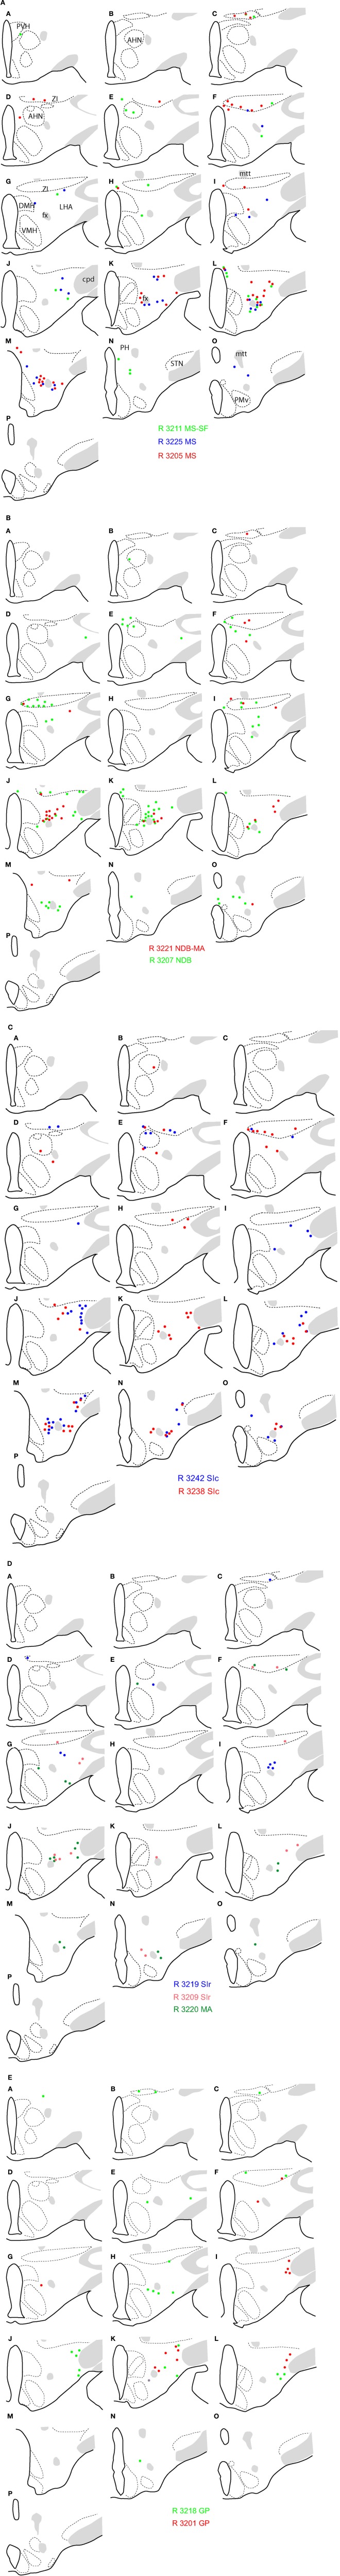
(A–E) Distribution of FG-MCH neurons in the posterior hypothalamus after different FG injections in the basal telencephalon. This distribution is mapped on coronal drawings of the caudal hypothalamus arranged from rostral (a) to caudal (p). These drawings were produced from Nissl stained sections and mapping was made with regard to the distribution of MCH cell bodies from an adjacent series of section. Therefore, results of all FG-injected brains were represented on this set of reference drawings and with regard to cytoarchitecture and to MCH distribution. One dot on the drawing corresponds to one MCH cell labeled by the fluorogold observed on the section. After septal injections (A,B) retrogradely labeled MCH neurons were medial in the hypothalamus, while after injection in the substantia innominata (C,D) or globus pallidus (E) retrogradely labeled perikarya were more lateral. Note the dense group of retrogradely labeled cells in the posterior perifornical region (j–m).